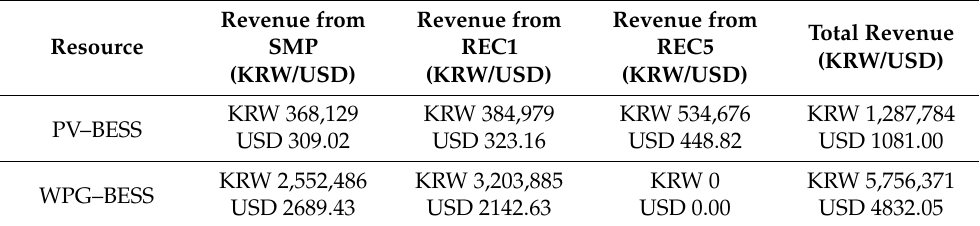
Table 10. Intraday revenue generated from the prior operating method.